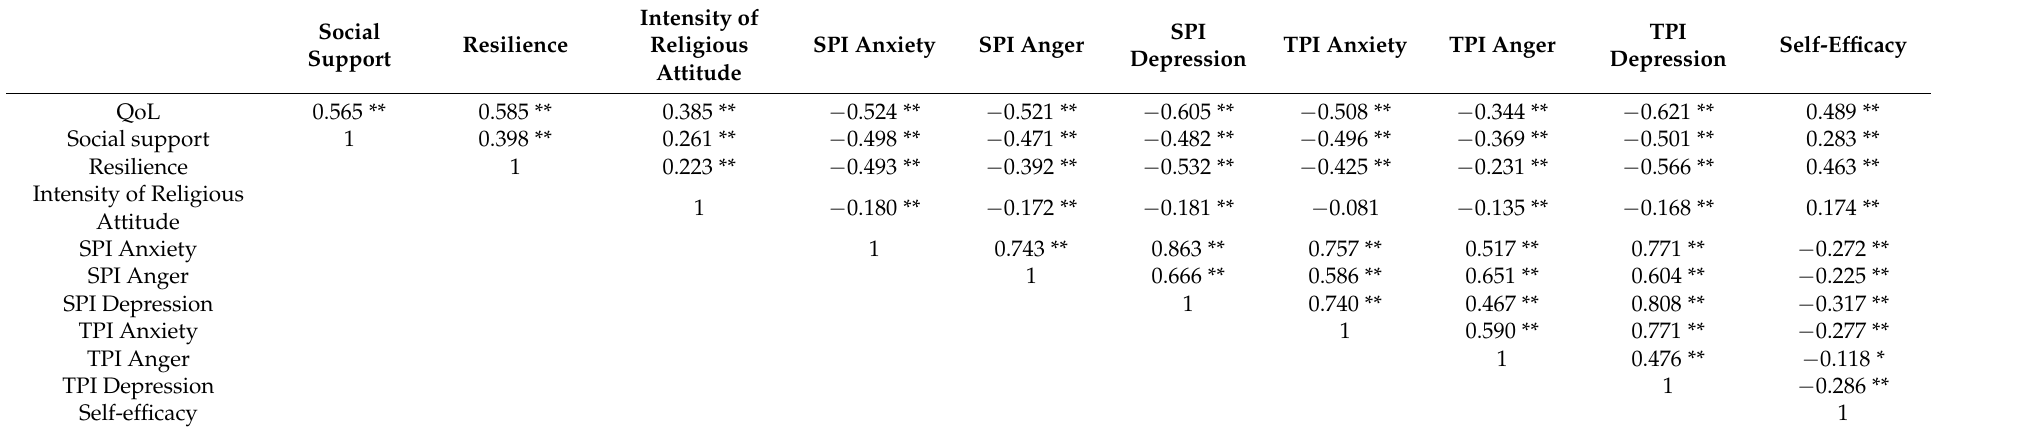
Table 3. Pearson’s product-moment correlation coefficients for QoL and its positive and negative correlates. Intensity of Social Resilience Religious Support Attitude